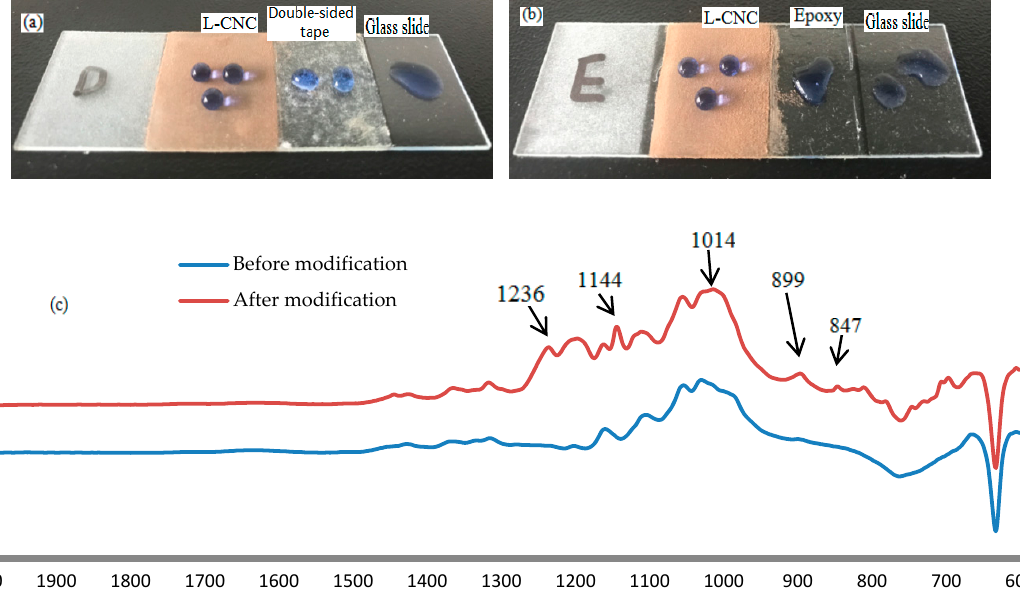
Figure 3. Status of water droplets on ( a ) the untreated glass slide, the double-sided tape, and the glass slide treated with D coating, and ( b ) the untreated glass slide, the epoxy, and the glass slide treated with E coating; ( c ) FTIR spectra of the L-CNC particles before and after modification.